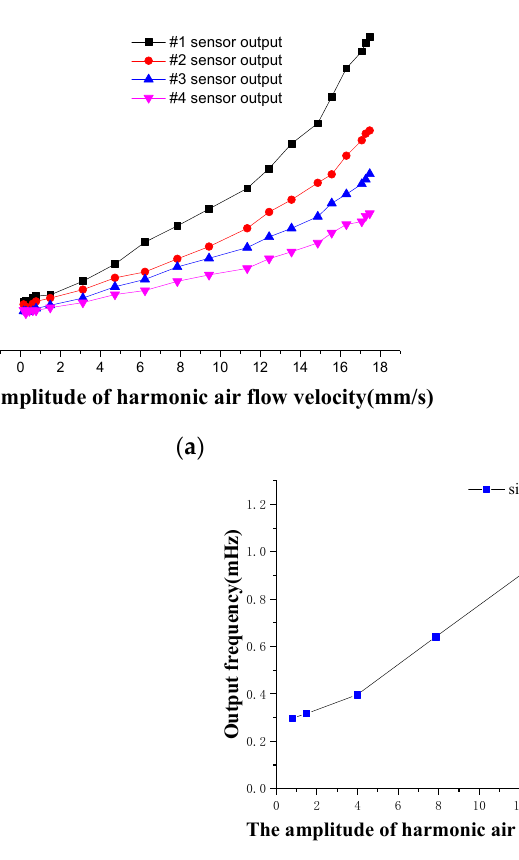
Figure 18. The amplitude-frequency characteristic curve of the resonator excited by the oscillatory air flow at 60 Hz.